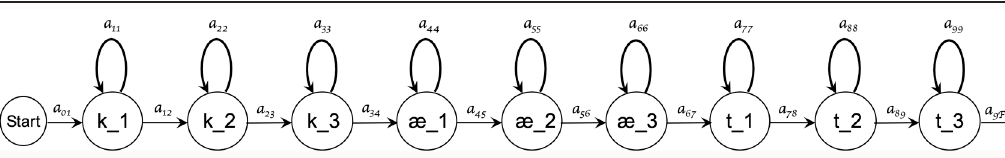
Figure 4: Raw HMM for ‘cat’.